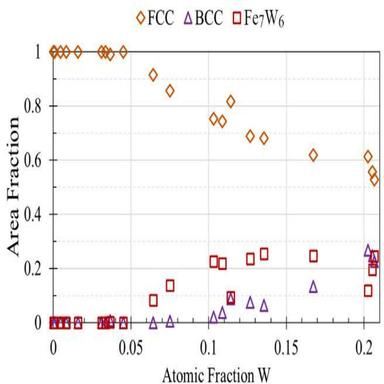
Approximate area fraction and concentration of W of each phase along the entire length of the specimen in the graded dimension.